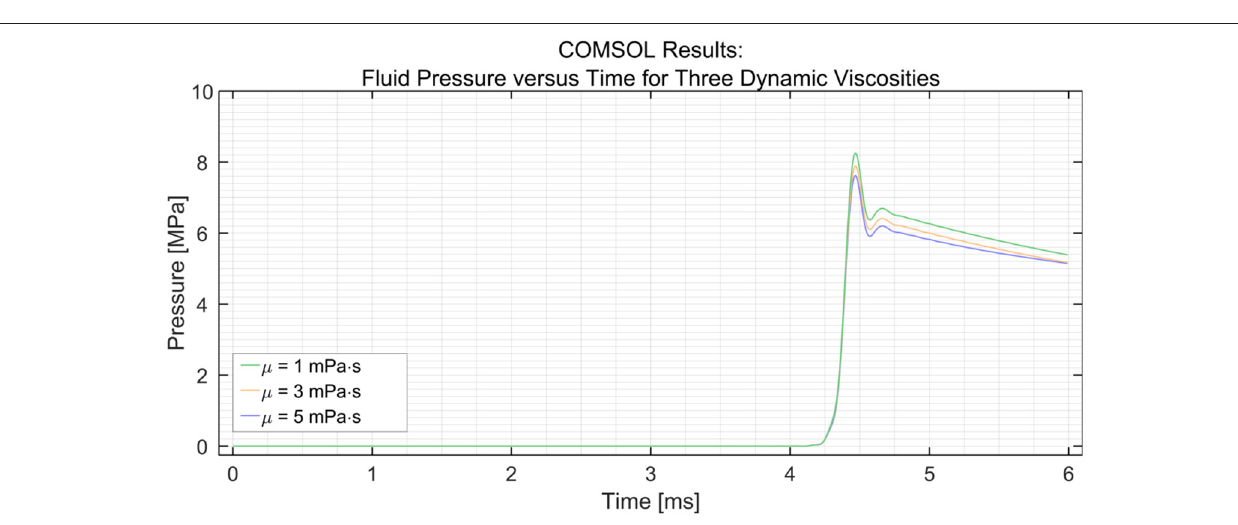
FIGURE 4 | Pressure variation at the distal end vs. time in the PTFE Shaft for three dynamic viscosities ( µ ) of the medium; 1, 3, and 5 mPa · s. The input pressure was set to 15